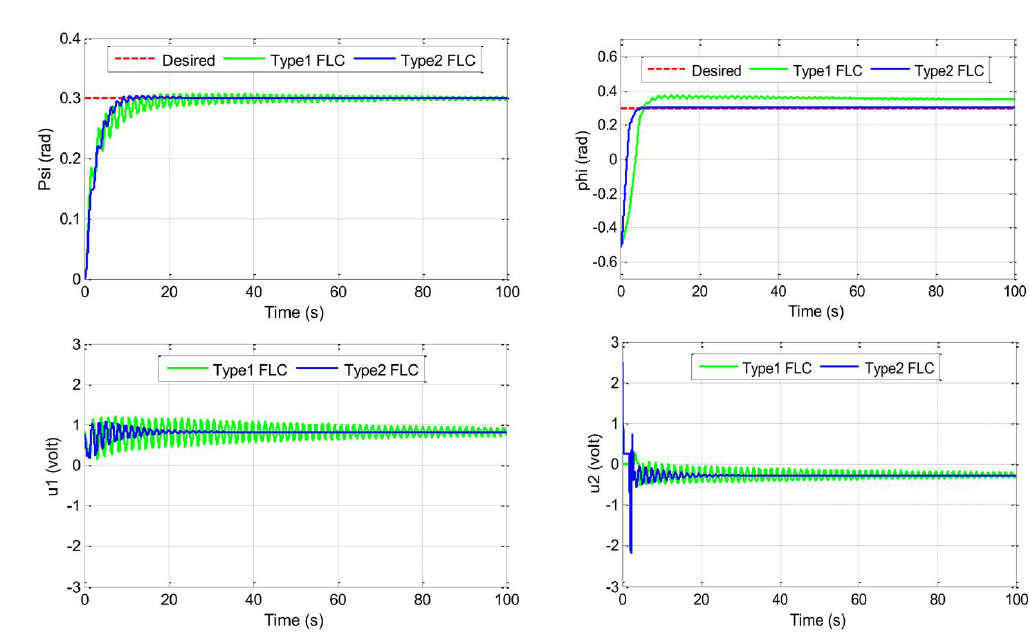
Figure 8. ψ and φ angles stabilization.